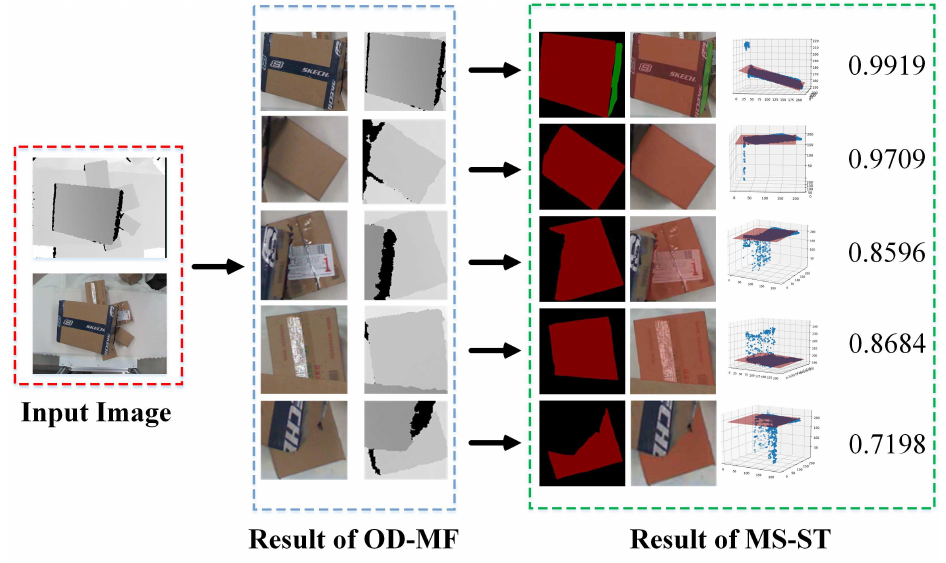
Figure 9. The result of MS-ST shows the accurate segmentation of the sorting region of parcels and the estimation of the occlusion